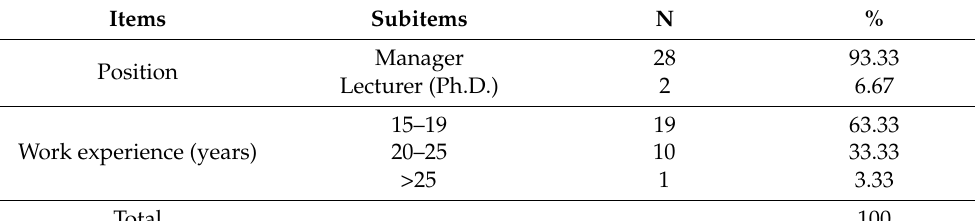
Table 2. Backgrounds of the respondents.